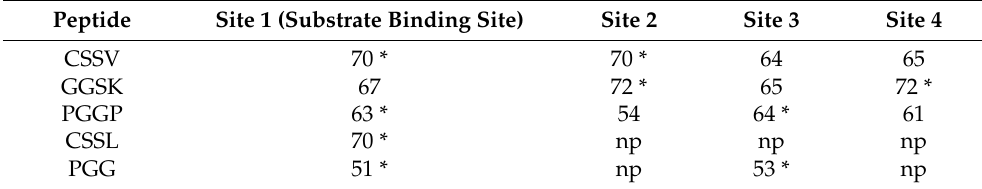
Figure 1. Surface representation of pancreatic alpha amylase. The yellow sphere indicates the location of the substrate binding site, while the green spheres indicate the location of the additional surface pockets considered in this study. Table 3. Docking scores of CSSV, PGGP, GGSK, CSSL and